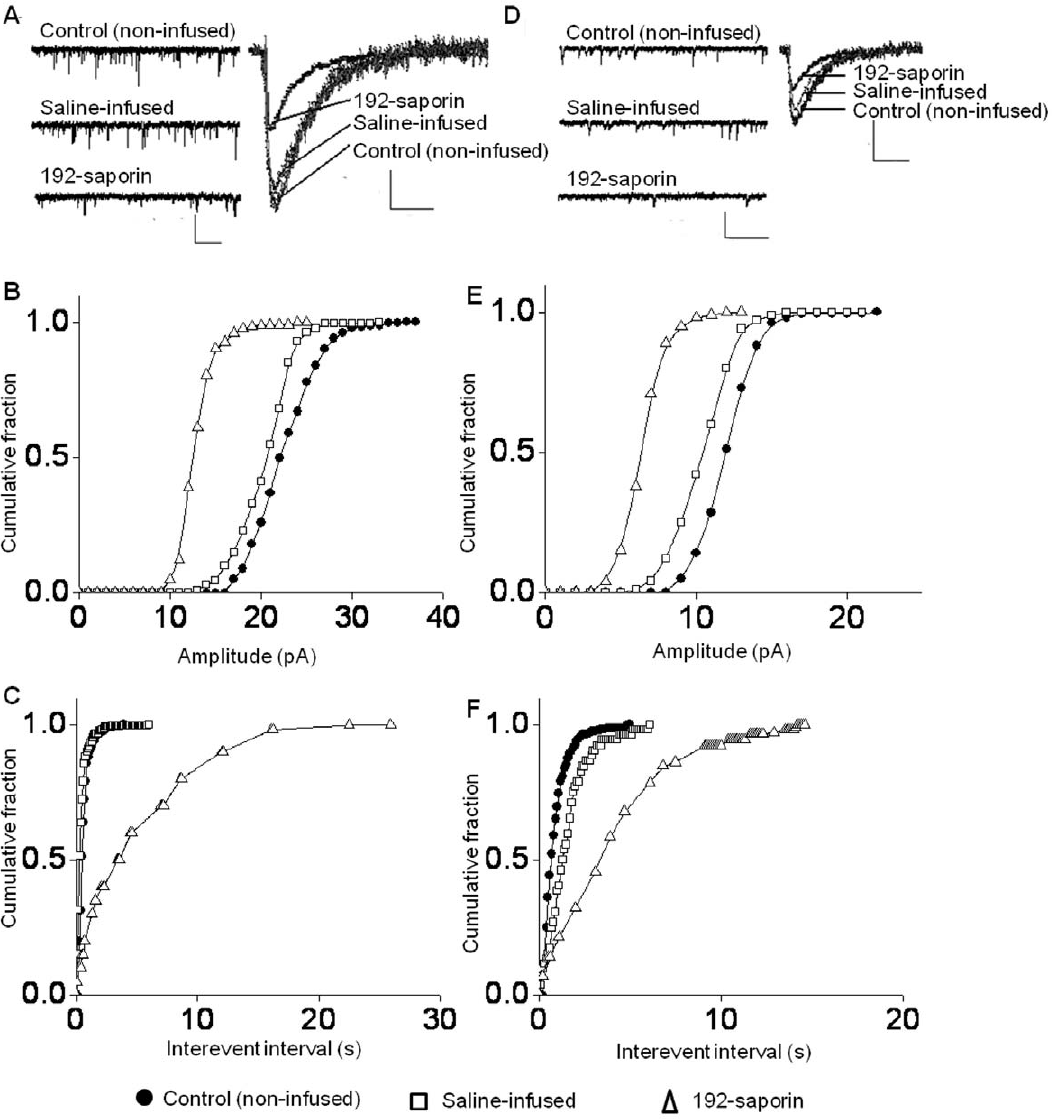
Figure 6. Lesioning of MS cholinergic pathway decreases the NMDA receptor mediated currents in the CA1 pyramidal neurons. (A) Representatives of NMDA receptor mediated sEPSC traces recorded at 2 40 mV membrane potential shows reduction of the frequency in the 192- saporin infused rats compared to the controls (Calibration: 40 pA, 1 s). The adjoining average traces of sEPSCs exhibit the reduction in amplitude in the 192-saporin infused rats (Calibration: 15 pA, 30 ms). Cumulative fraction curves of (B) amplitude and (C) interevent interval showing reduction in amplitude and frequency in the 192-saporin infused rats. (D) Representative segments of NMDA mediated mEPSCs (Calibration: 10 pA, 1 s) and average mEPSCs (Calibration: 10 pA, 30 ms) depicts reduced amplitude and frequency in the 192-saporin infused rats compared to the two controls. Cumulative fraction curves for (E) amplitude and (F) interevent interval of mEPSCs.